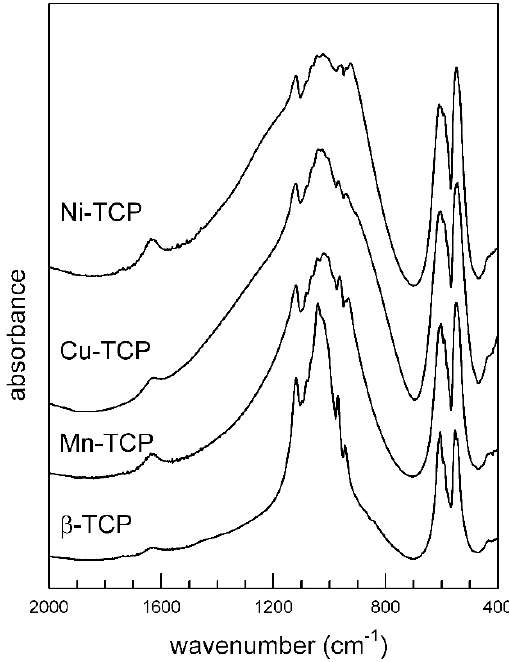
Figure 7. FTIR spectra in the wavenumber range (2000–400 cm − 1 ) of Me 2 + β –TCP studied compounds in comparison with pure β –TCP [15]. Table 5. Measured absorption in the FTIR spectra and relative assignments for Ca 2 . 90 Me 0.10 (PO 4 ) 2 (Me = Mn, Ni, Cu) in comparison with data for pure β -TCP